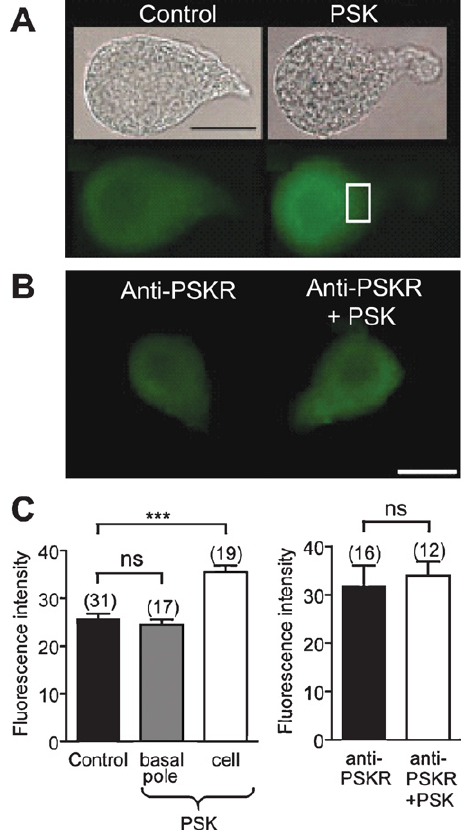
Figure 8. PSK increases the cAMP level in DUM neurons . ( A ) Bright field images and cAMP immunostainings of isolated DUM neurons in the absence (left) and in the presence of 10nM PSK (right). ( B ) cAMP immunostainings in cells incubated with antisera anti-PSKR in the absence (left) and in the presence of 10nM PSK (right). ( C ) Histograms showing the intensity of immunofluorescence for the indicated conditions in the basal pole (square, see (A)) and in the cell body. A large increase in cAMP immunostaining intensity was observed in the cell body whereas but not at the basal pole (left). In DUM neurons preincubated with PSKR antisera cAMP immunostaining was not affected by PSK (right). ***Significantly different, p < 0.001, Student’s t- test; ns, not significant. Scale bar, 30 m m .